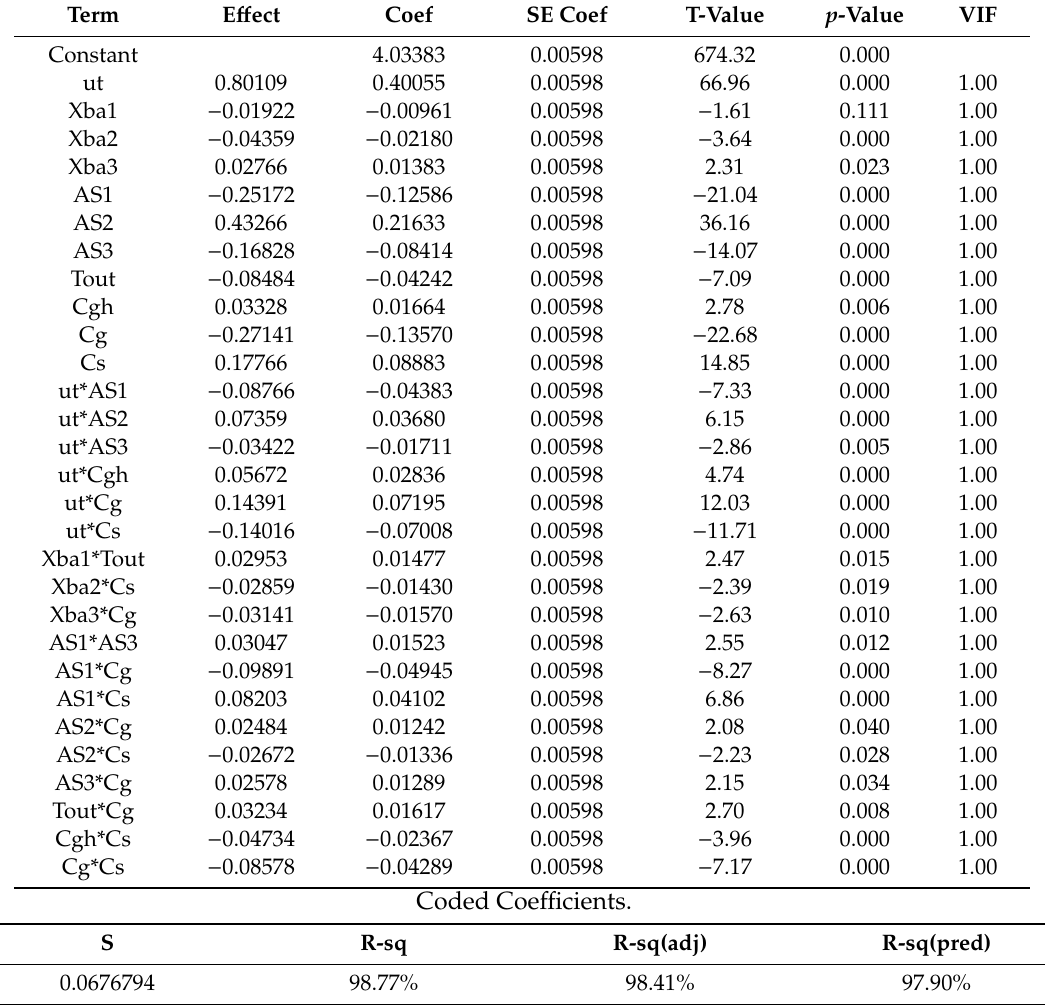
Table 4. Estimated E ff ects and Coe ffi cients for u 2